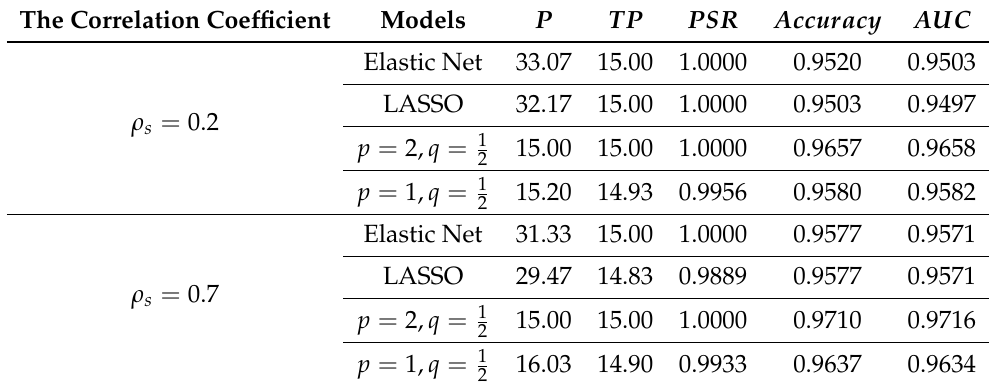
Table 1. The results for the simulations in experiment